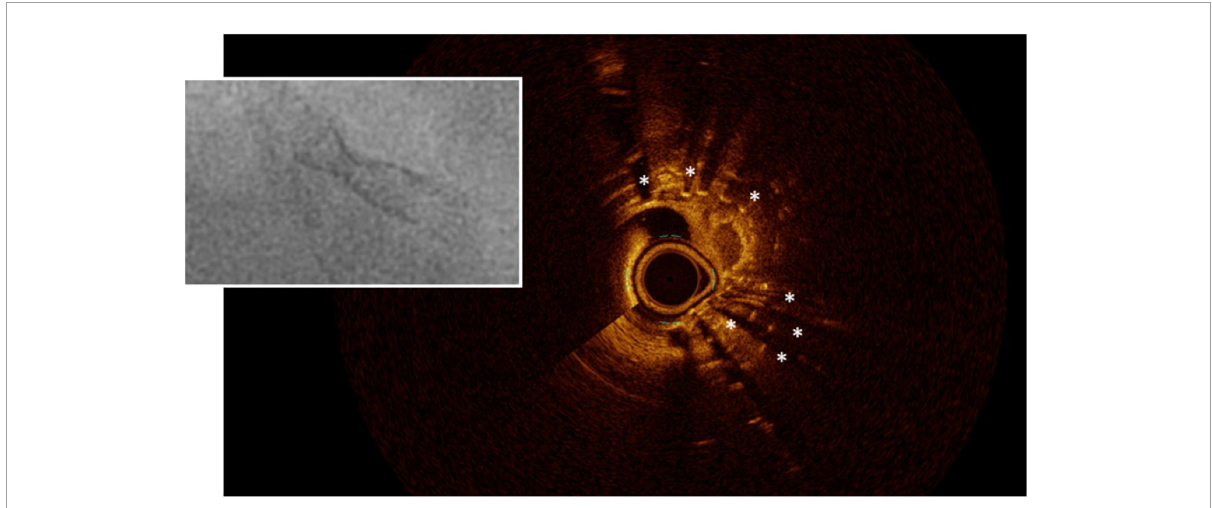
FIGURE2 Stent underexpansion. OCT image of an incomplete expansion of a stent resulting in restenosis despite moderate neointima proliferation. The asterisks (*) mark stent struts. The small picture demonstrates the incomplete apposition at